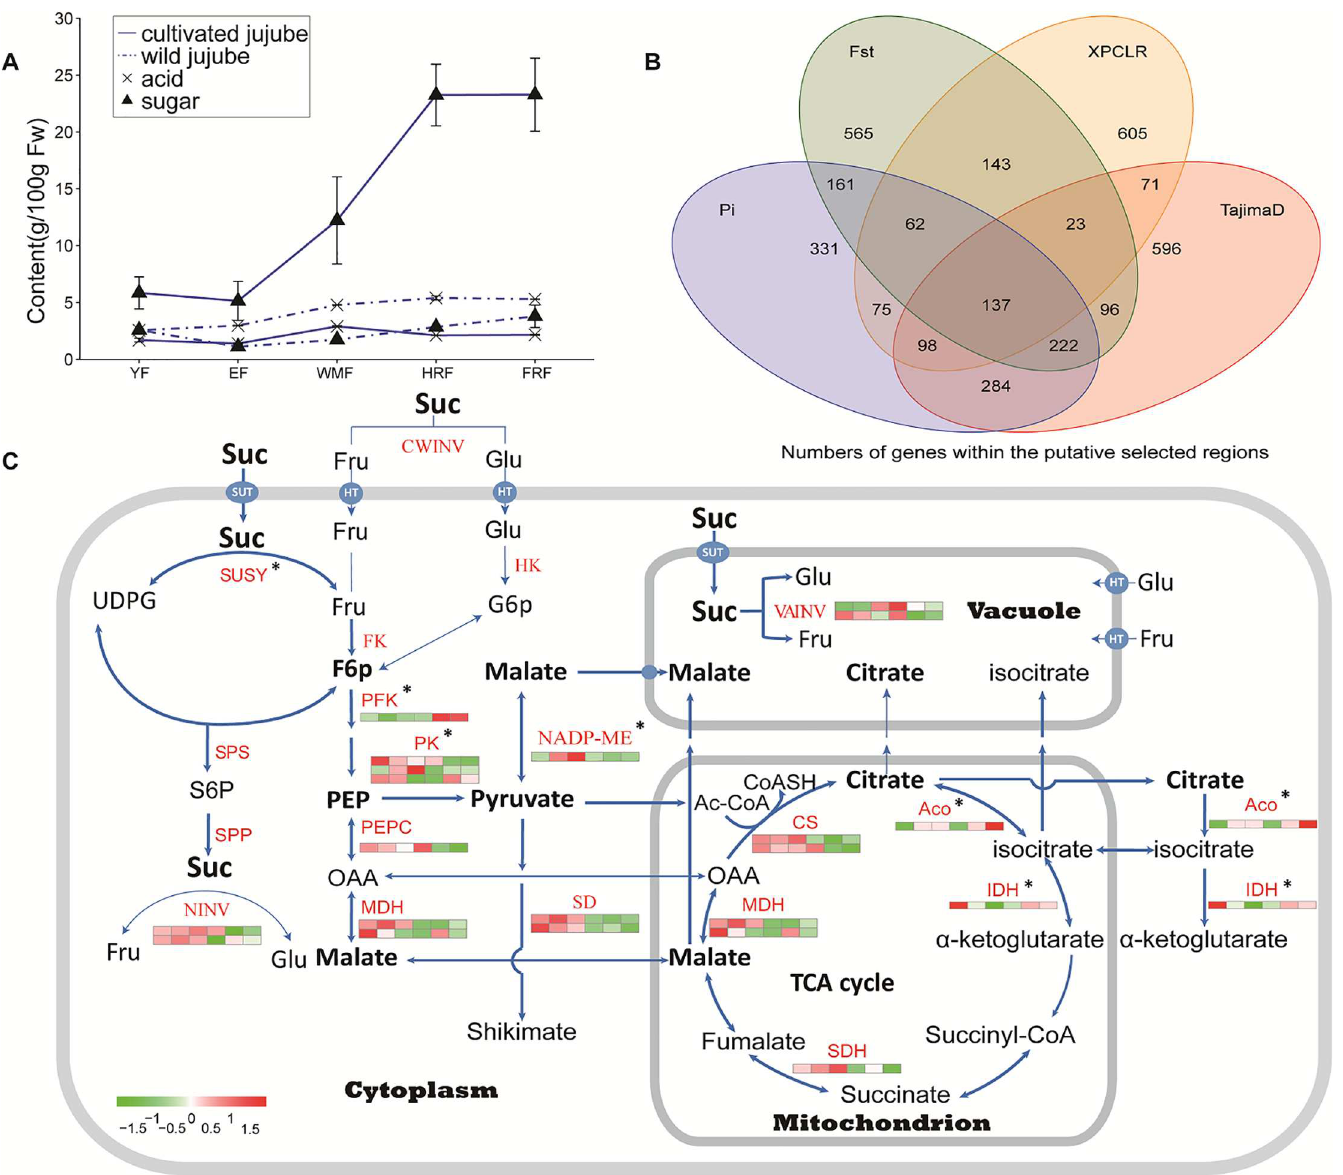
Fig 3. Jujube sugar and acid metabolism associatedwith domestication. (A ) Sugar and acid accumulation in fruits at variousdevelopmental stages from cultivatedand wild jujubes.YF, young fruit; EF, expandingfruit; WMF, white mature fruit; HRF, half-red fruit; and FRF, full-red fruit. ( B ) Number of genesdetected in the putative selective regionsusing different methods. ( C ) Transcript abundanceof genes involvedin sugar and acid metabolism in cultivatedand wild jujubes. Stars indicatethe genesthat were locatedin the regions putativelydetected as selective sweeps. Scaledlog 2 expressionvalues (RPKM) are shown in the heat map legend. The six boxes in one row of each heat map (left to right) correspond to the expressionlevels at stages EF, HRF and FRF of the wild accession (‘Qingjiansuanzao’) and WMF, HRF and FRF of the ‘Junzao’cultivar. Each row in the heat map corresponds to one gene. SUSY: sucrose synthase; SPS: sucrose phosphate synthase; SPP: sucrose-phosphatase; HK: hexokinase;FK: fructokinase; PK: pyruvate kinase; MDH: malate dehydrogenase; ACO: aconitatehydratase; IDH: isocitrate dehydrogenase; SDH: succinate dehydrogenase; CS: citrate synthesis; NINV: neutral invertase; CWINV: cell wall invertase; vAINV: vacuolaracid invertase; PFK: